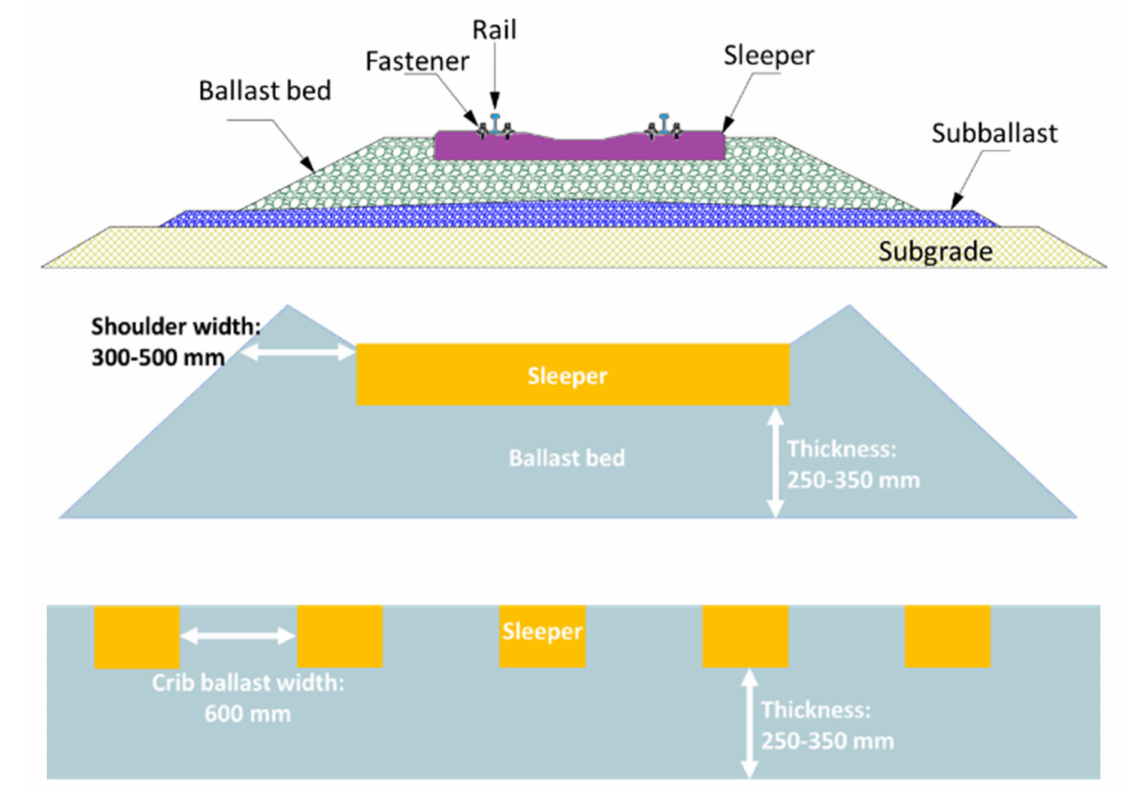
Figure 1. Ballasted track (figure reproduced from